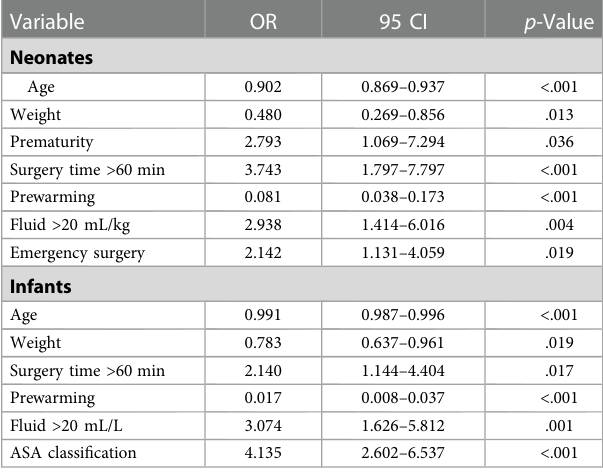
TABLE 4 Risk factors associated with intraoperative hypothermia in neonates and infants.